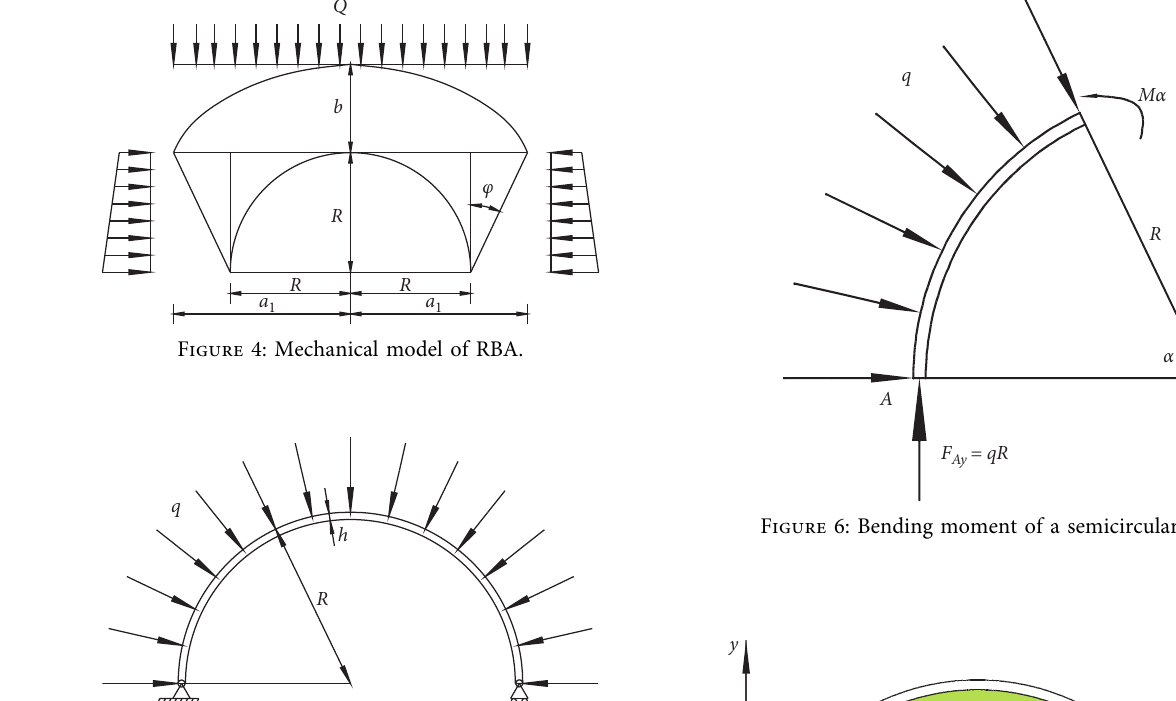
Figure 5: Simplified stress model of half-cylinder arch.